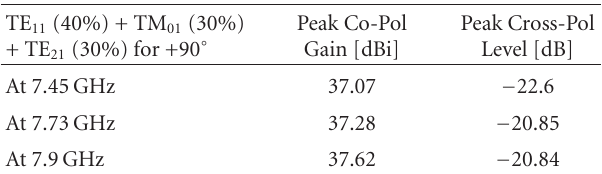
Table 4: Copolarization gain and peak cross-polarization level (below peak gain) values within bandwidth for the selected mode